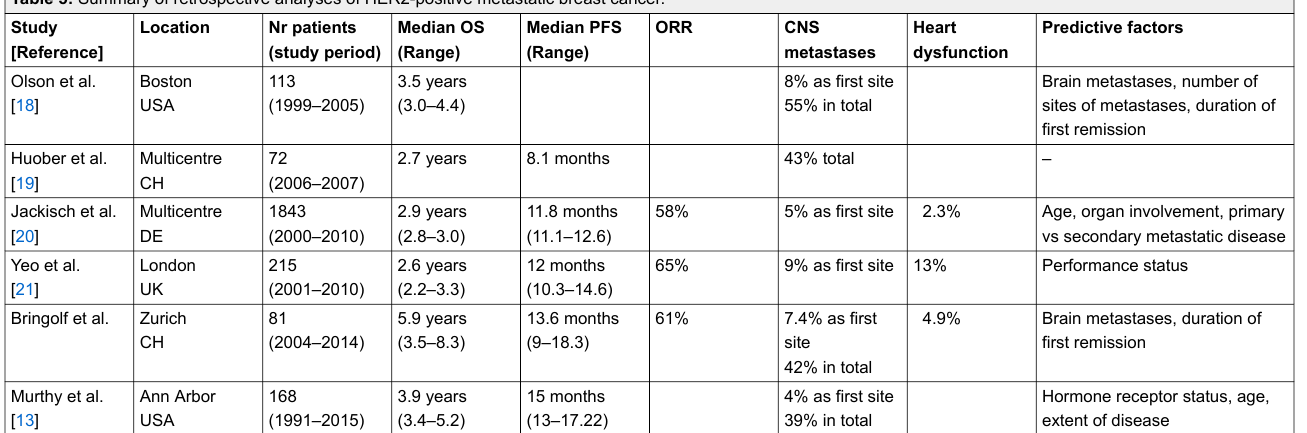
Table 5: Summary of retrospective analyses of HER2-positive metastatic breast